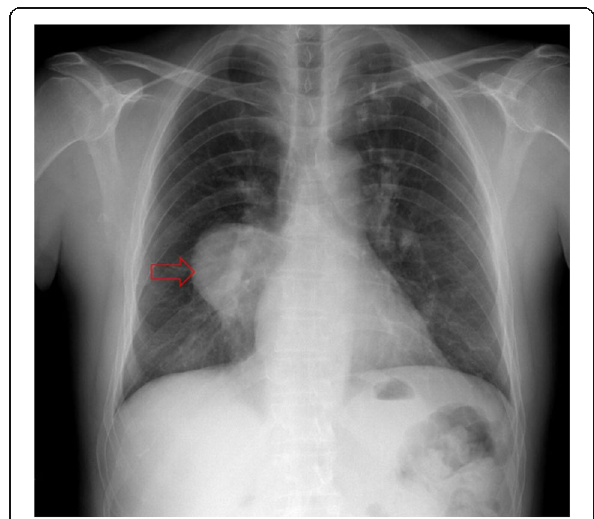
Fig. 1 Hydatid cyst has a non-specific appearance on chest radiography